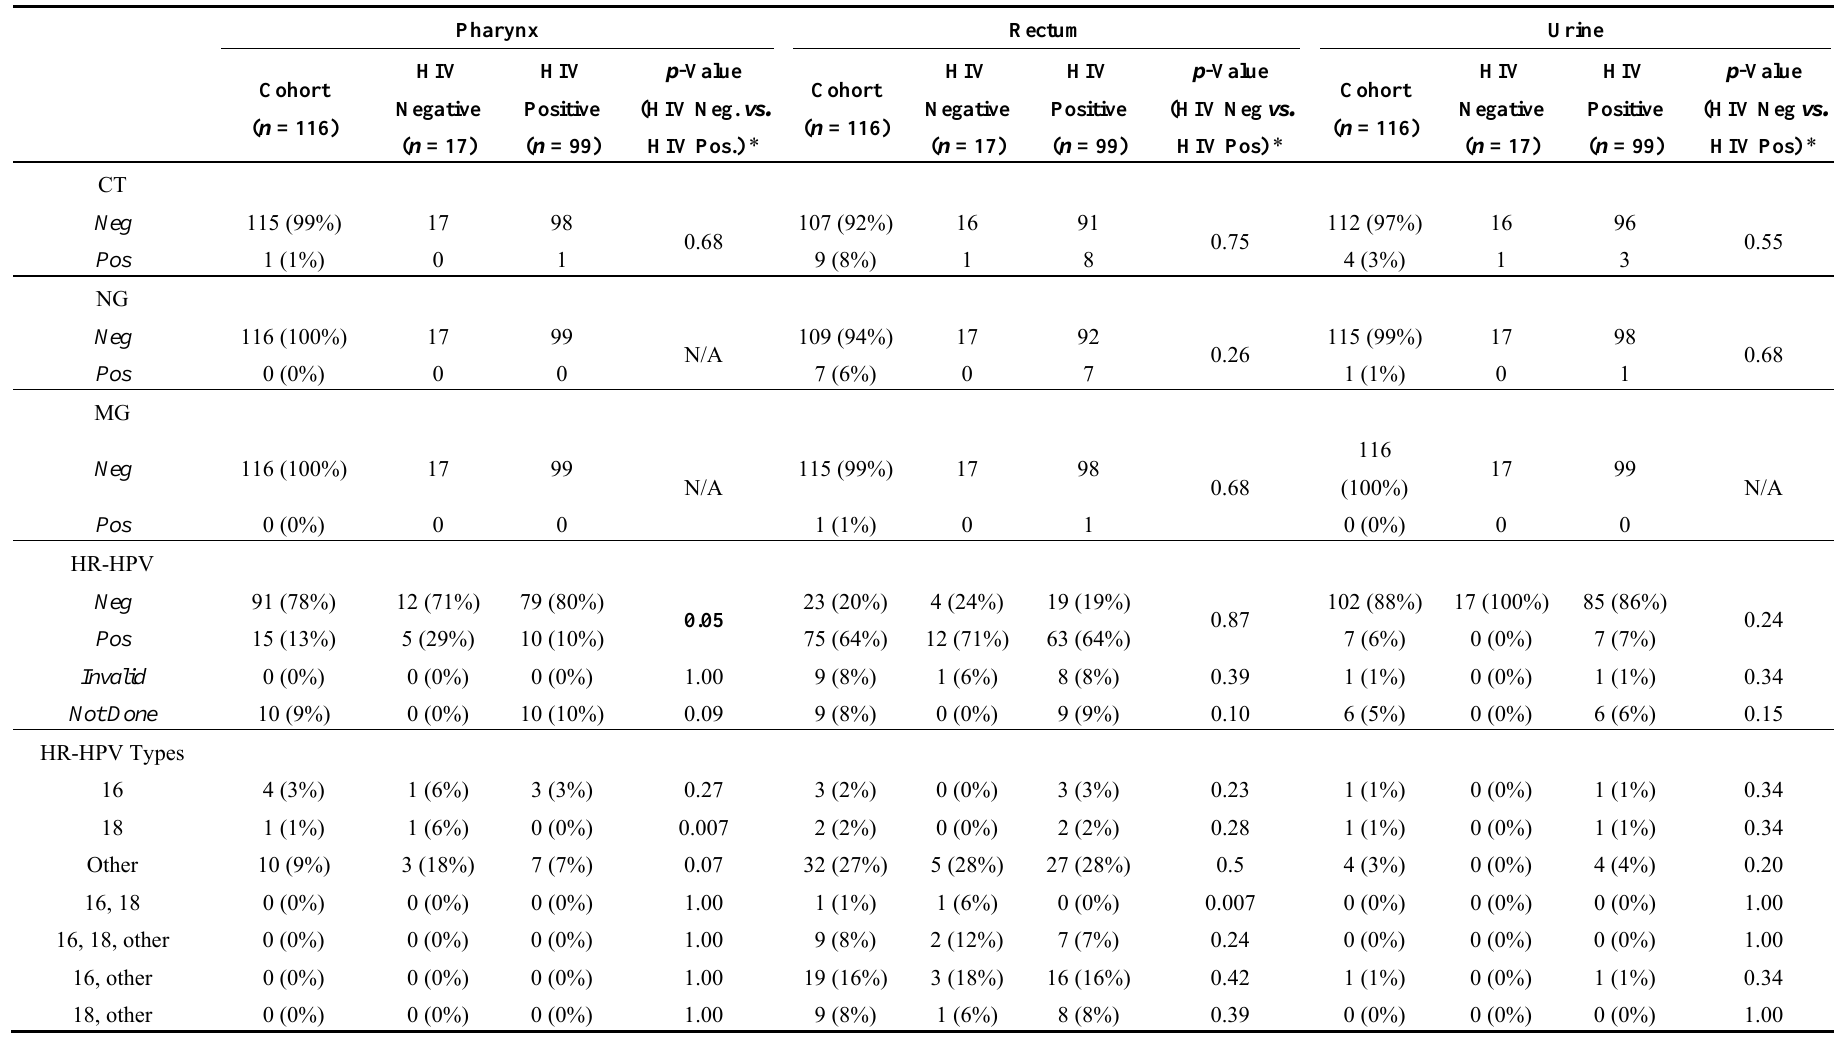
Table 1. Anatomic distribution of neisseria gonorrhoeae (GC), chlamydia trachomatis (CT), high risk human papillomavirus (HR-HPV) and mycoplasma genitalium (MG) in the pharynx, rectum and urine, according to HIV